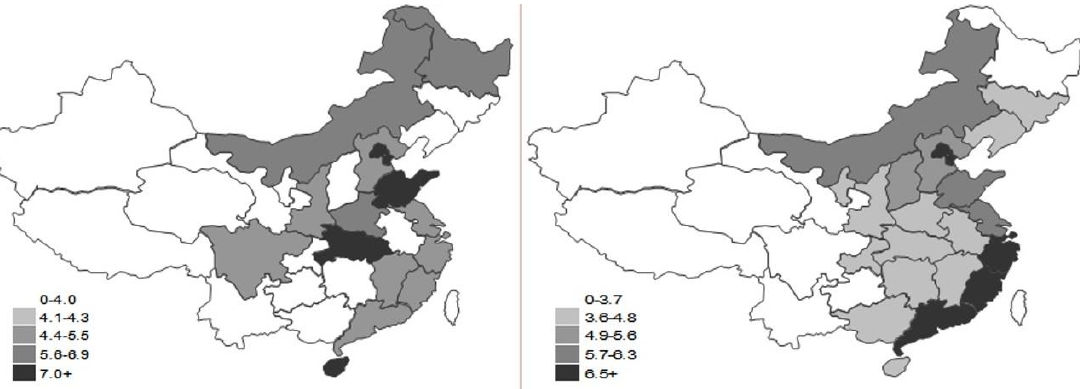
Figure 5. Map of drive sub-index in 2000 and 2015.